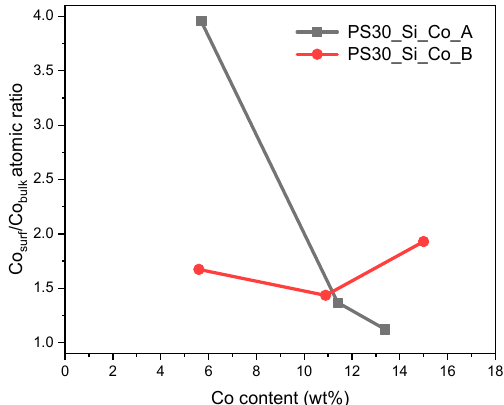
Figure 7. Relationship between the Co surf /Co bulk atomic ratio and the total cobalt content in the studied yolk–shell catalysts.